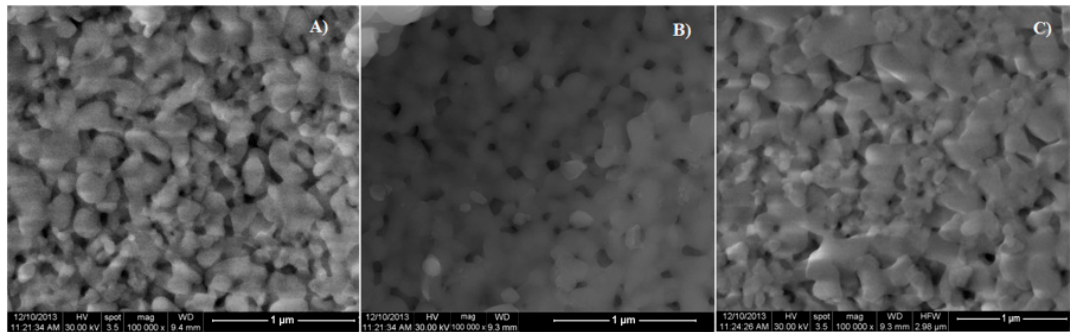
Figure 1. SEM images of HAp ( A ); T-HAp ( B ) and C-HAp ( C ) thin films.